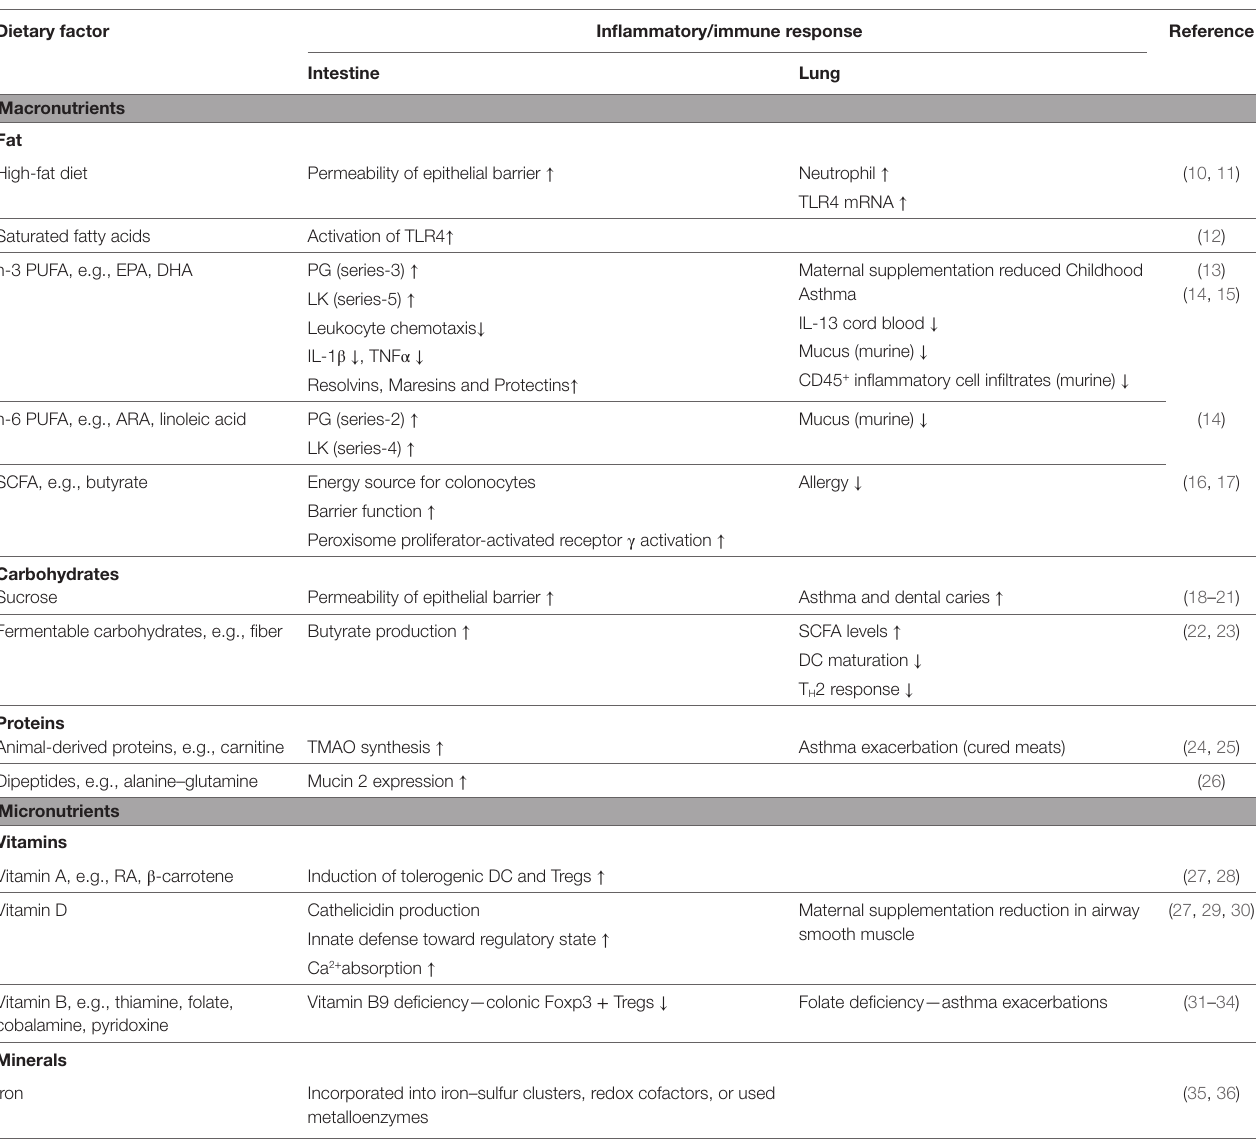
TABLe 1 | Dietary factors and host inflammatory responses at mucosal sites. Dietary